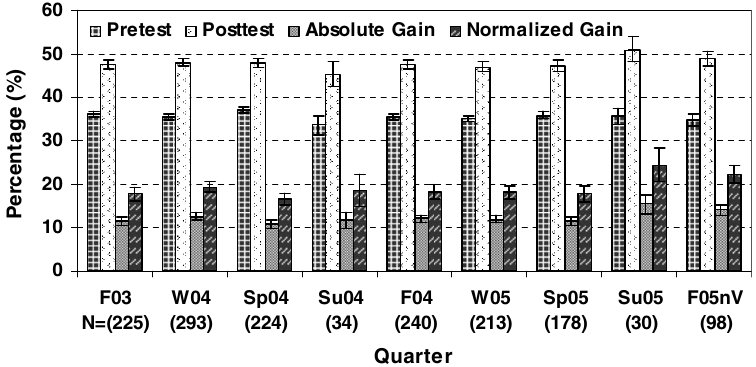
FIG. 1. The pre-test averages, post-test aver- ages, absolute gains, and normalized gains for the individual quarters in the comparison group. (cid:1) The error bars denote standard errors.